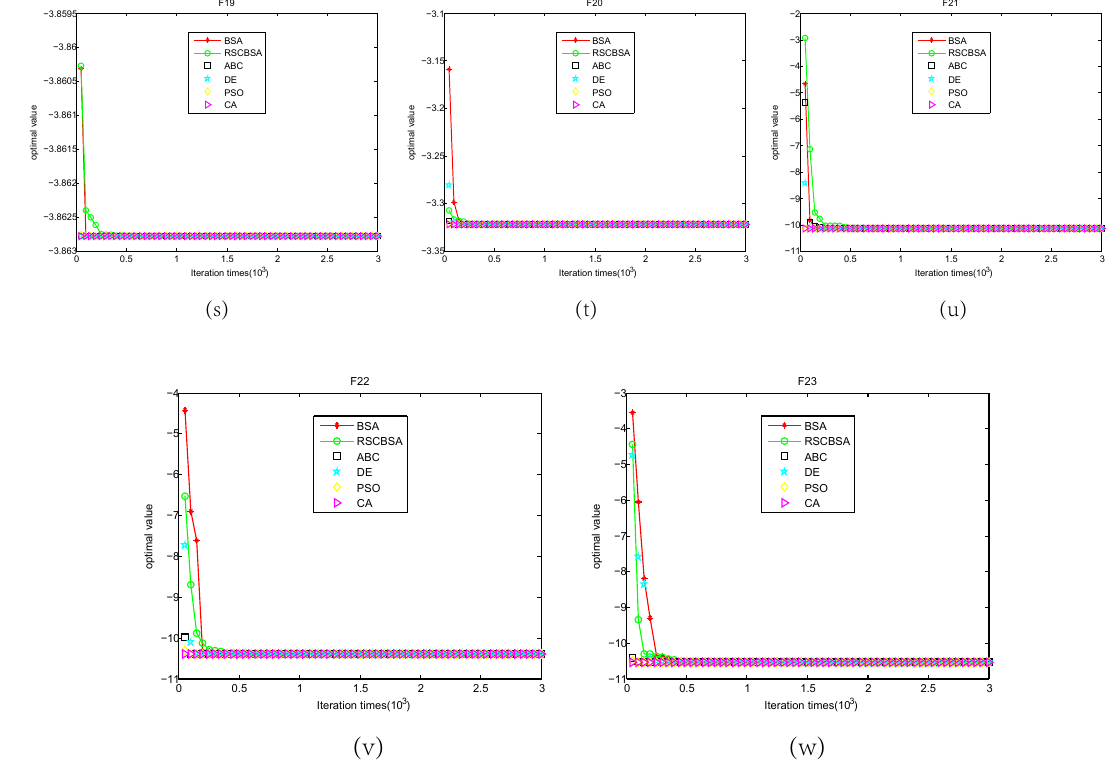
Figure 1. Convergence figures on test functions F1–F23, where ( a – w ) indicate the convergence curves on the functions F1–F23 respectively.